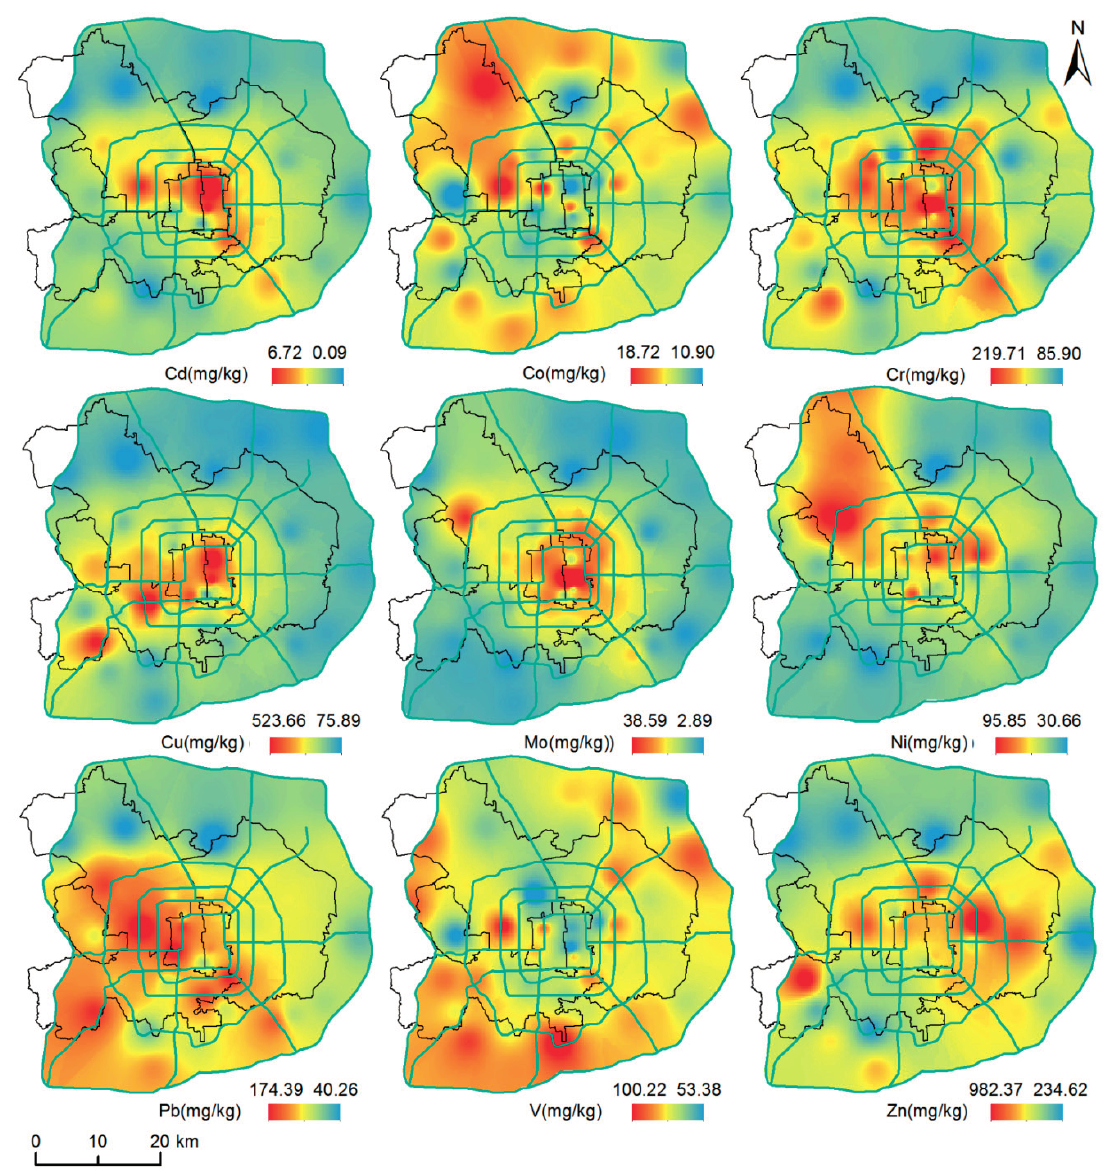
Figure 3. Spatial distributions of heavy